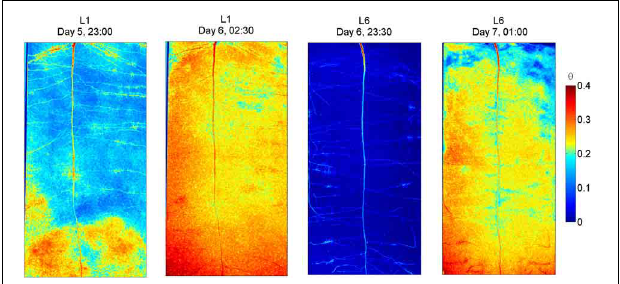
FIGURE 4 | Neutron radiography of L1 and L6 before and after irrigation. L1 was irrigated every second day. Before irrigation its average water content was 0.17. After irrigation, the rhizosphere of the upper and middle part was not fully rewetted. Low and young roots were rewetted. L6 experienced a longer and more pronounced drying and was irrigated when its water content was 0.02 and the plant showed wilting symptoms. After irrigation the rhizosphere of most roots was not rewetted, except at the root tips, which appeared being covered with a blob of wet material.